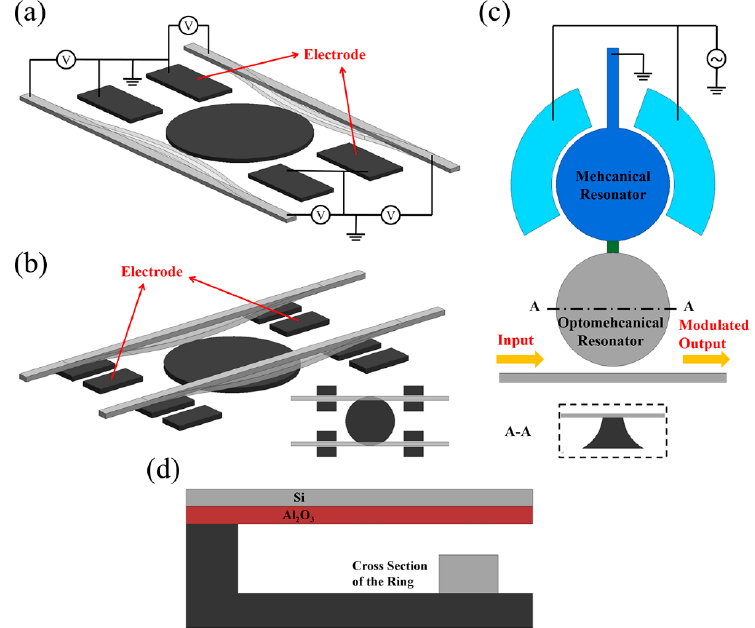
Figure 7. Schematics of ( a ) in-plane and ( b ) out-of-plane tuning mechanisms for dynamic add-drop filters, a disk resonator is coupled with suspended channel waveguides; ( c ) illustration of a dynamic optical intensity modulation controlled by an electrically-excited mechanical resonator (top view); and ( d ) cross-section view of the ring resonator system with thermal feedback using a bi-material thermal actuator.